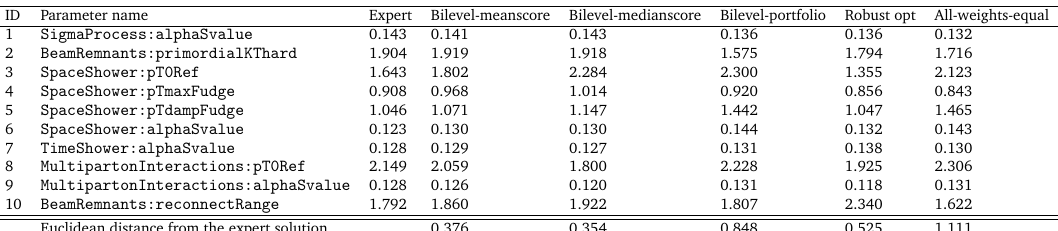
Table 25: Optimal parameter values obtained for A14 with the cubic polynomial ap- proximation with all methods after using the bin-filtering approach that excludes individual bins from the